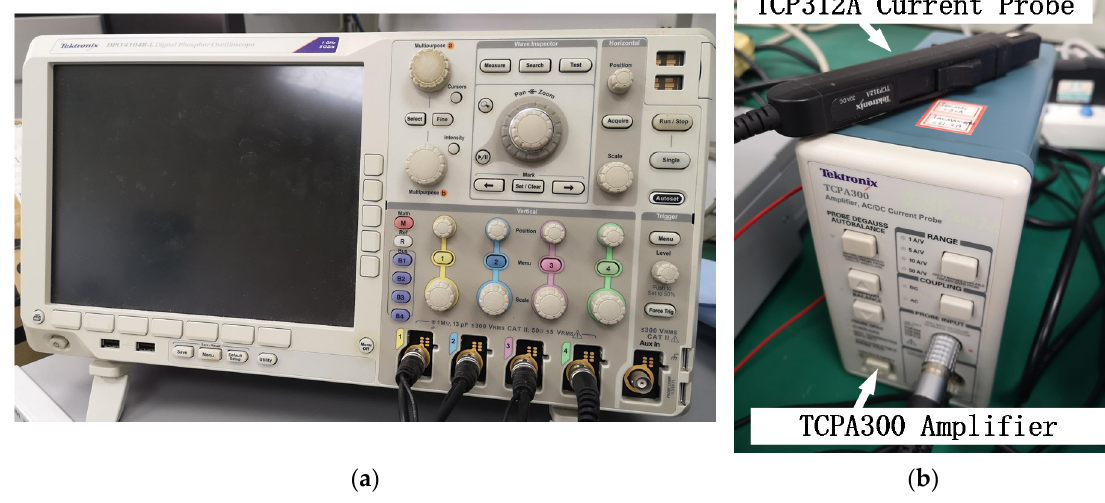
Figure 6. Photos of the sampling devices: ( a ) oscilloscope; ( b ) Hall current sensor.